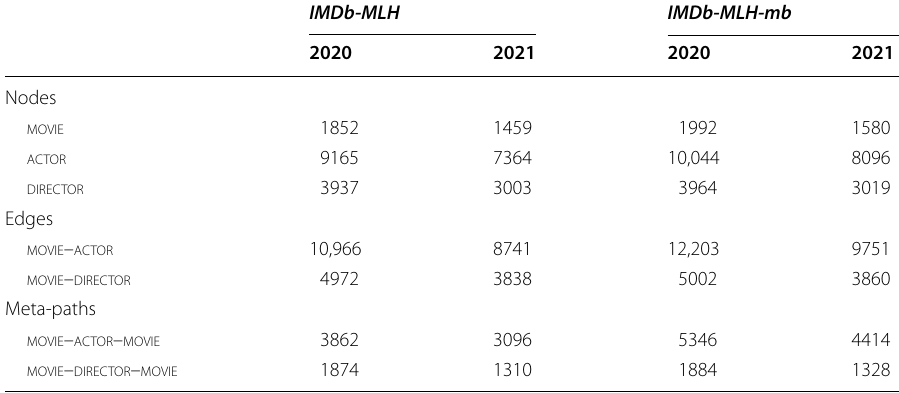
Table 1 Summary of within-layer network statistics